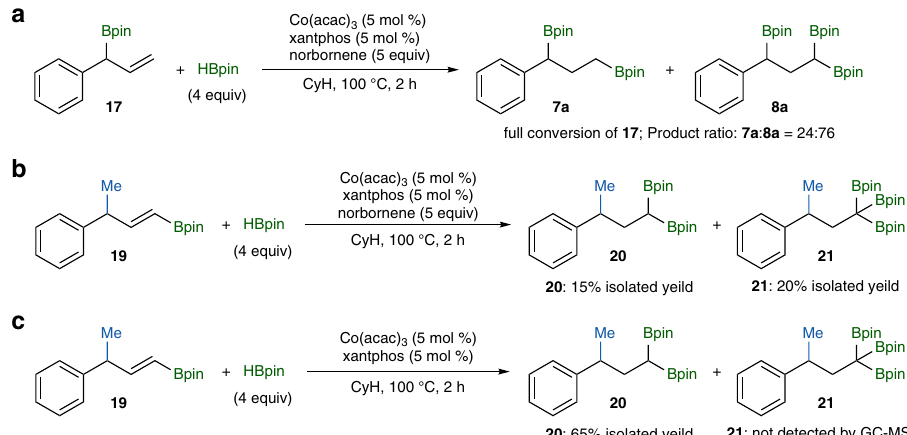
Fig. 5 Control experiments to con fi rm possible reaction intermediates. a gem -diborylation reaction of 17 with HBpin under standard reaction conditions. b The reaction of 19 with HBpin in the presence of norbornene as a hydrogen acceptor. c The reaction of 19 with HBpin in the absence